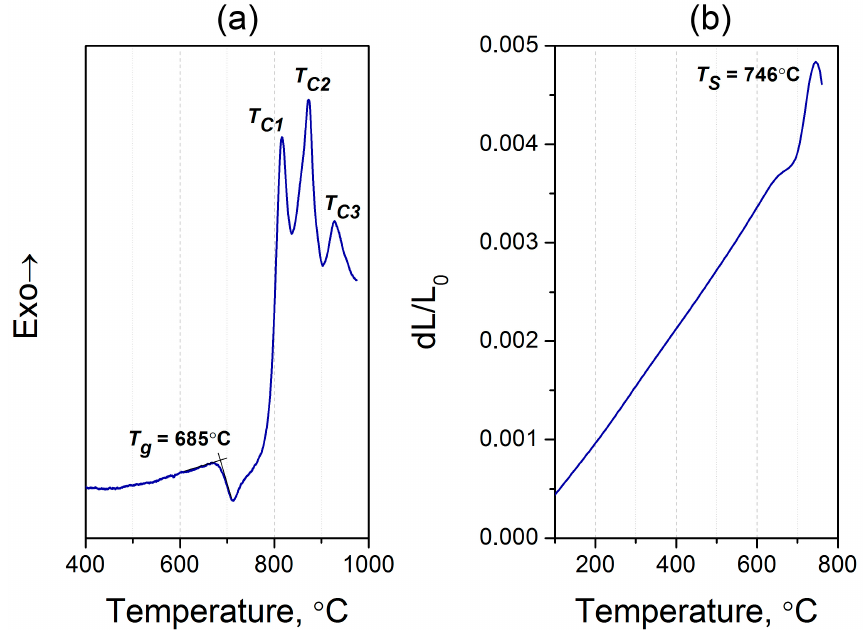
Figure 1. ( a ) The DSC curve, and ( b ) the dilatometric curve of the initial glass.